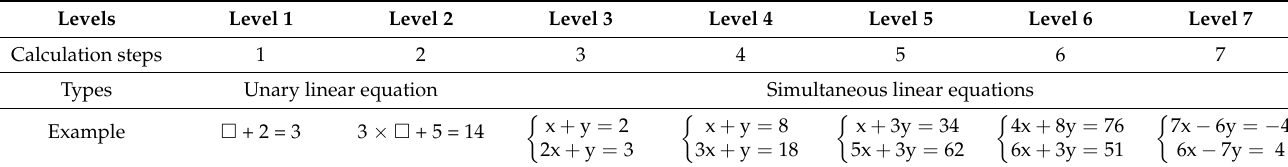
Table 1 details the information on seven levels of difficulty designed in this study. Table 1.